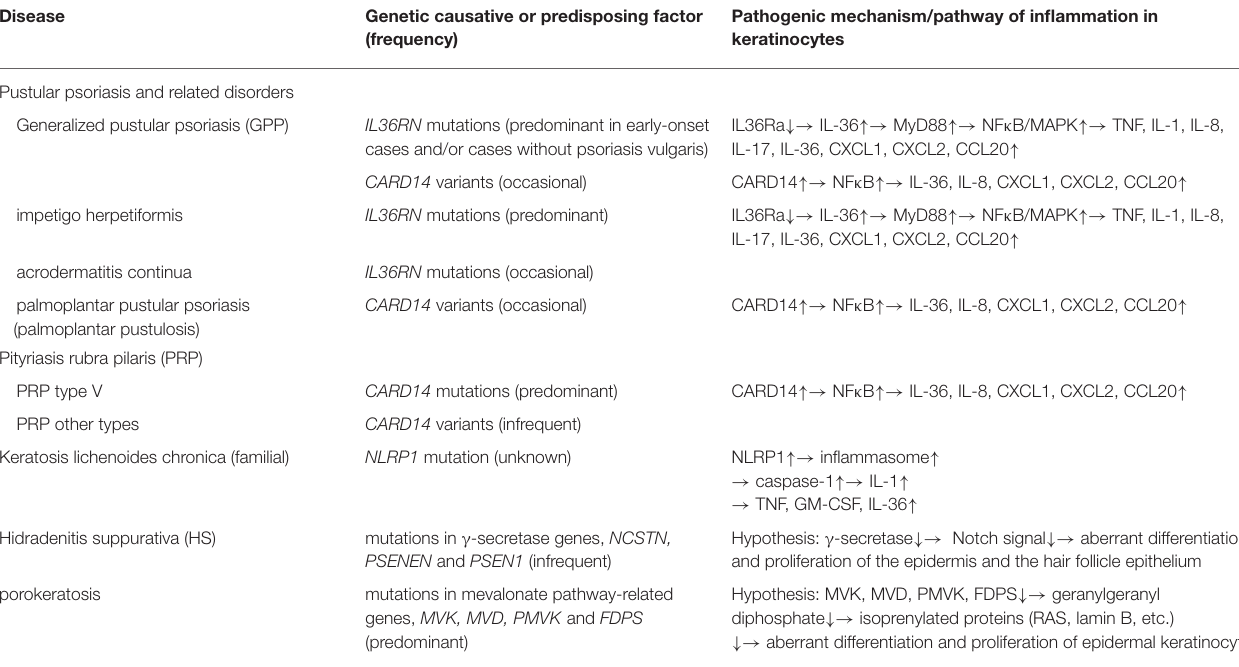
TABLE 1 | Inflammatory keratinization diseases classified as AiKDs to date [adopted and modified from Akiyama et al. (1, 2)]. Disease Genetic causative or predisposing factor Pathogenic mechanism/pathway of inflammation in (frequency) keratinocytes Pustular psoriasis and related disorders Generalized pustular psoriasis (GPP) IL36RN mutations (predominant in early-onset IL36Ra ↓→ IL-36 ↑→ MyD88 ↑→ NF κ B/MAPK ↑→ TNF, IL-1, IL-8, cases and/or cases without psoriasis vulgaris) IL-17, IL-36, CXCL1, CXCL2, CCL20 ↑ CARD14 variants